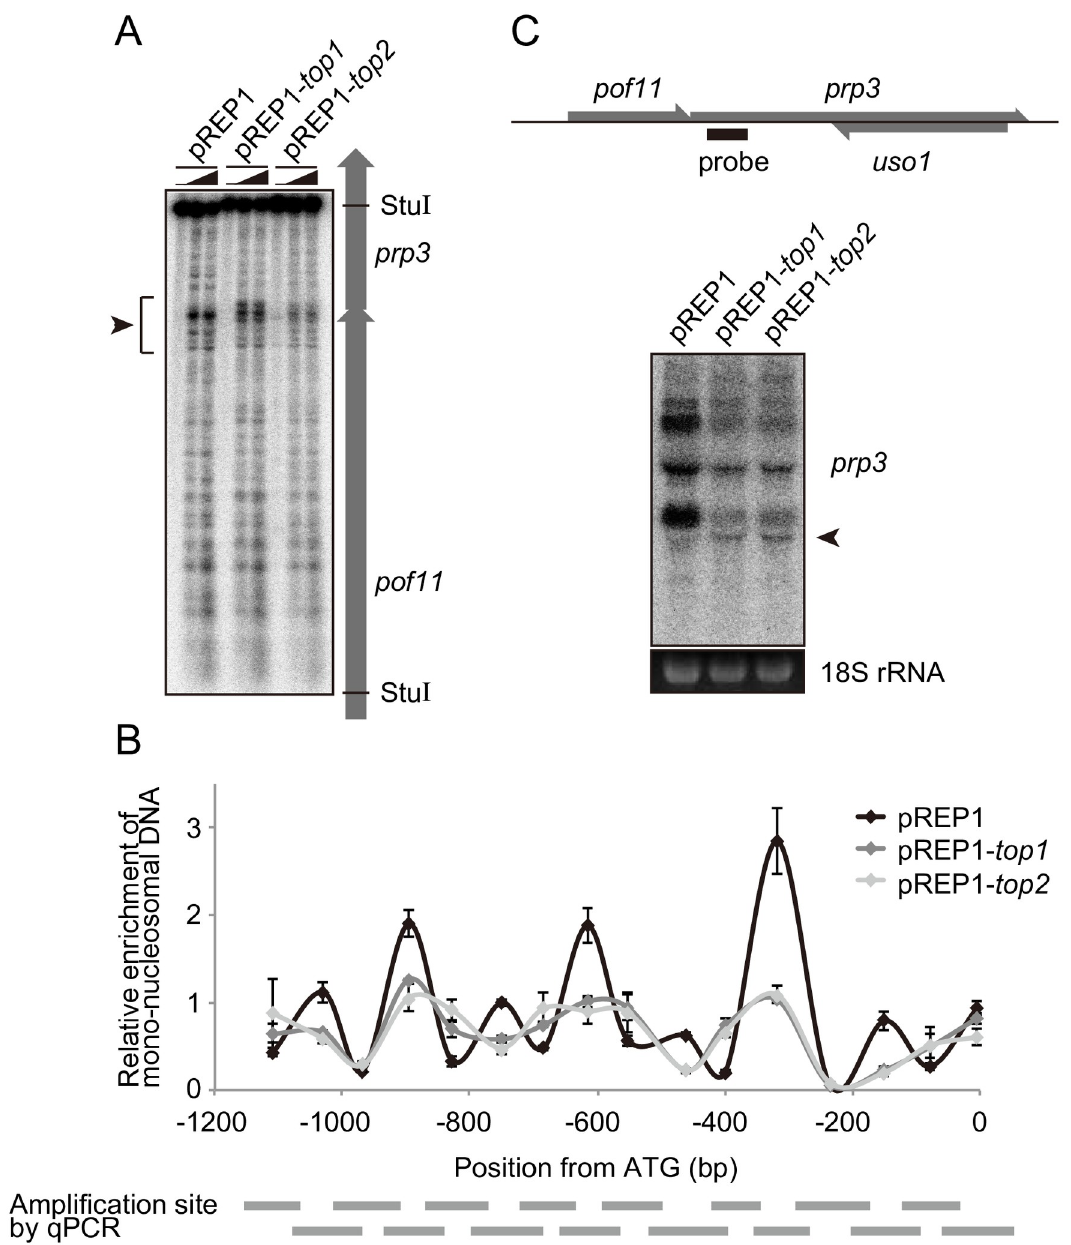
Fig 5. Topoisomerase overexpression destabilizes positioned nucleosomes at the prp3 promoter. (A) Chromatin state at the prp3 locus was analyzed by a MNase partial digestion assay in glucose-rich conditions in wild-type and topoisomerase overexpressing cells. The MNase-digested DNA samples used in Fig 3A (0 min) were digested by Stu I and subjected to Southern blot analysis. (B) Mono- nucleosome mapping at the prp3 locus. Purified mono-nucleosomal DNA used in Fig 4 was analyzed by qPCR using primer sets covering the prp3 upstream region and the 5 0 region of the gene body. The gray bars represent 16 segments across the prp3 upstream region and 5’ region of gene body (detected by qPCR). Horizontal axis indicates the position from the prp3 gene start codon (A of ATG = +1). The error bars indicate standard deviation in three biological replicates. (C) Representative image of a northern blot showing prp3 transcript levels in top1 -overexpressing and top2 -overexpressing cells as compared to control. Arrowhead indicates a transcript unique to the topoisomerase overexpressing cells. 18S rRNA levels detected by ethidium bromide staining is shown as a loading control.